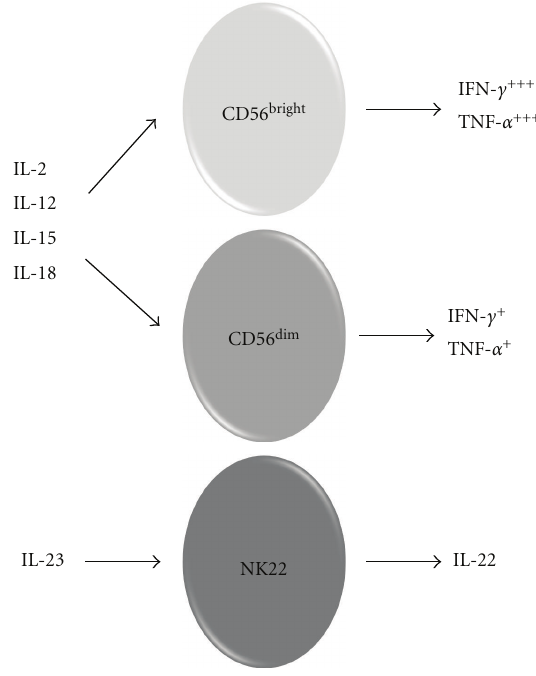
Figure 2: Subsets of NK cells secrete distinct cytokine profiles. Conventional NK cells, consisting of CD56 bright and CD56 dim subsets, are found in the general blood circulation. They are responsive to cytokines, with IL-2, IL-12, IL-15, and IL-18 being viewed as most important. These cytokines, some of which may act alone while others are only e ff ective in as part of a milieu, activate e ff ector functions such as secretion of cytokines including IFN- γ and TNF- α and degranulation of cytotoxic granules. In contrast, NK22 cells are a recently described subset of NK cells that are primarily resident in mucosal sites within the body. They di ff erentiate towards the NK22 phenotype in response to IL-23 stimulation. NK22 cells secrete IL-22 cytokine (but not IL-17). IL- 22 is known to be pathogenic in